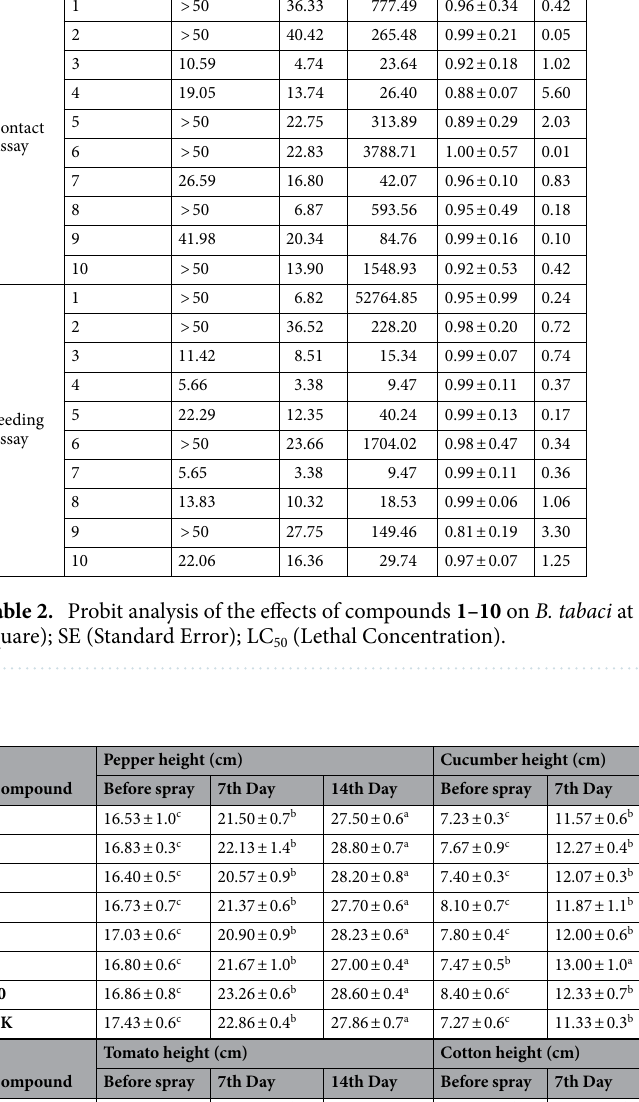
Table 3. Effects of active compounds on crop heights at 100 µg/mL. Data in the columns presented as mean values ± standard error with various superscripts are significantly different according to DMRT (P > 0.05).